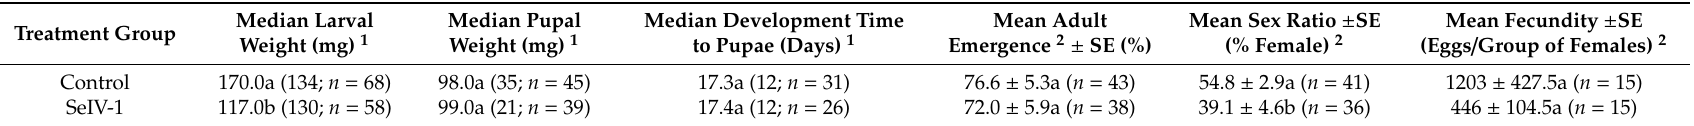
Table 1. Sub-lethal e ff ects of SeIV-1 infection on S. exigua in terms of the larval weight (at 144 hpi), pupal weight, development time to pupa, adult emergence, sex ratio and fecundity of groups of five females held